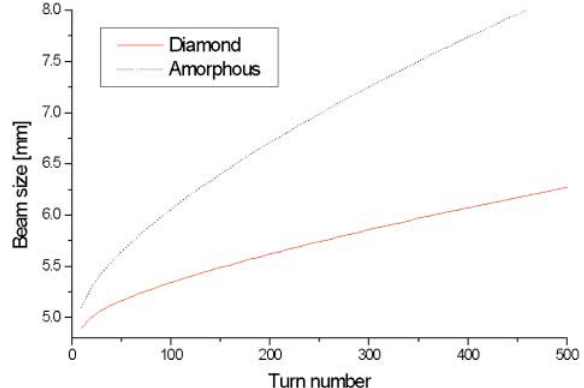
FIG. 4. (Color) The reduction factor in multiple Coulomb scat- tering angle, Dc (cid:3) E (cid:1) B (cid:4)(cid:2) s , for channeled particles as a func- tion of transverse energy based on the (cid:5) 110 (cid:6) axial potential in diamond.